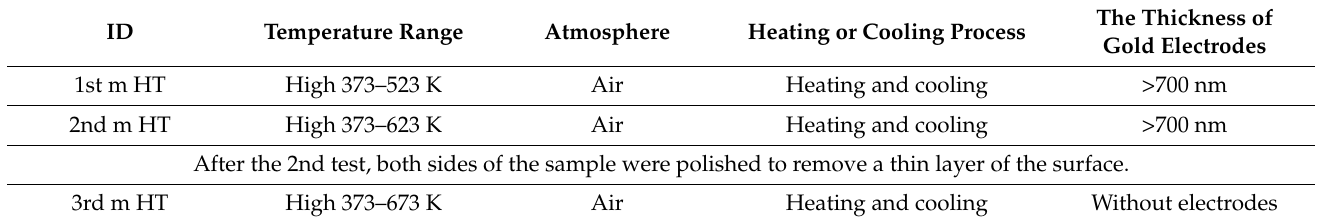
Table 2. The list of conditions used for the electrical measurements of the 10 Mg